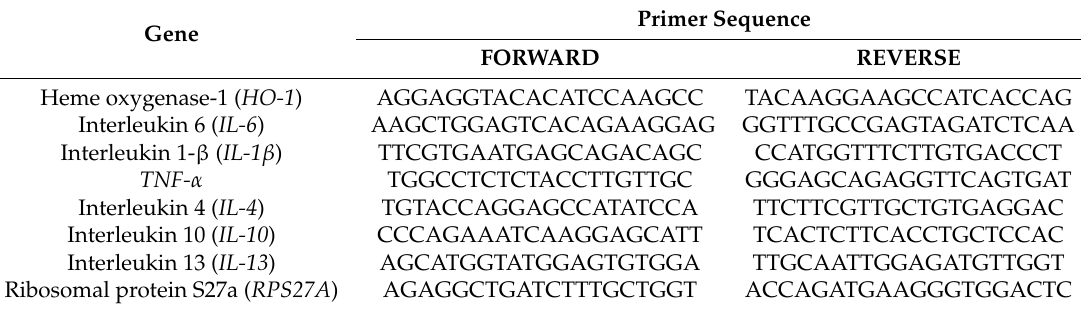
Table 2. Primers used in Real-Time PCR